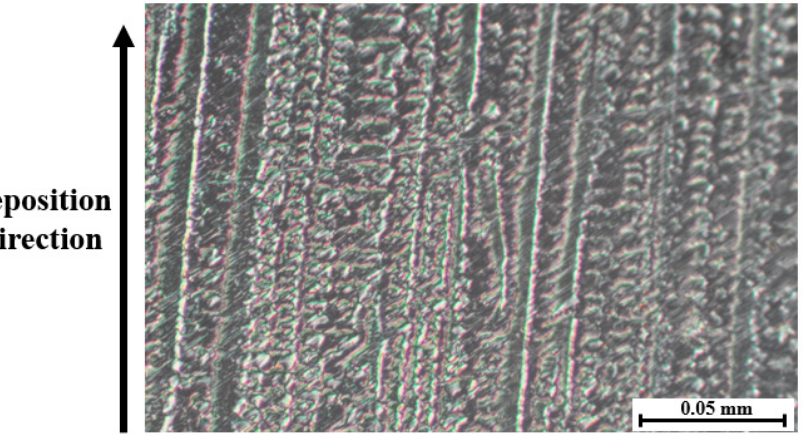
Figure 13. WAAM Inconel 718 microstructure.